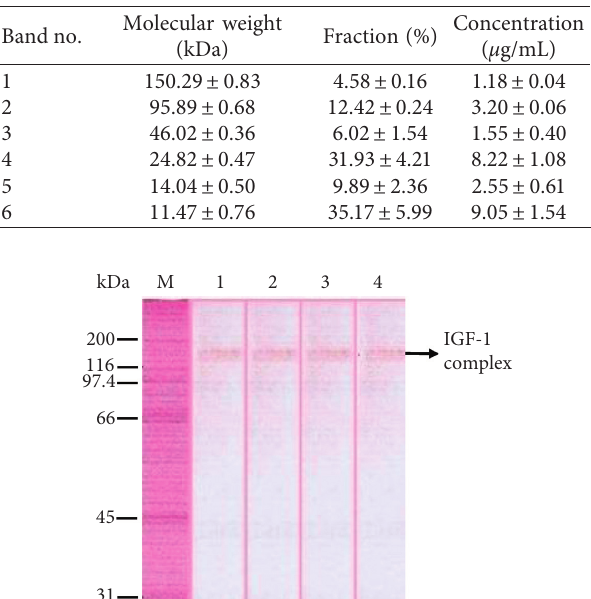
Figure 1: Sodium dodecyl sulfate-polyacrylamide gel electro- phoresis image of protein bands for Simmental bull seminal plasma protein. kDa: kilo Dalton, M: marker, 1 and 2: seminal plasma of first Simmental bulls, and 3 and 4: seminal plasma of second Simmental bulls. Table 1: The average molecular weight (kDa) proteins, percentage or fraction, and concentration (ng/mL) of Simmental bull seminal plasma.